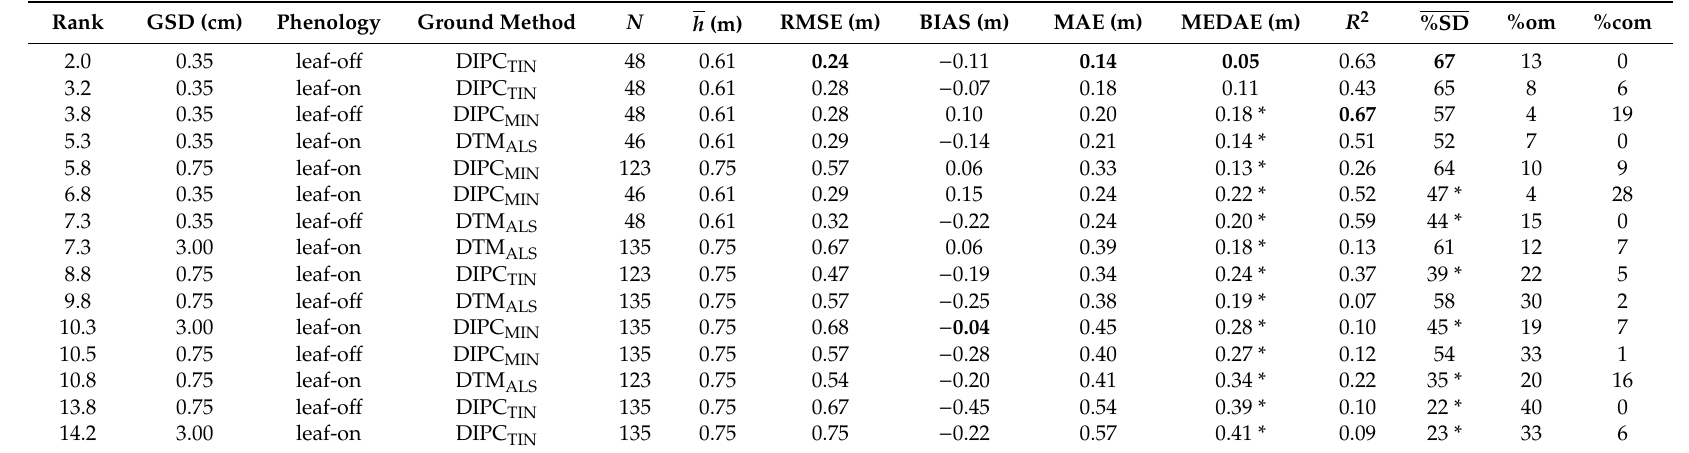
Table 3. Results for seedlings > 30 cm, ordered by the mean value of their ranking in each of the six metrics (e.g., the mean ranking for the 0.35 cm leaf-o ff DIPC TIN is (1 + 6 + 1 + 1 + 2 + 1) / 6 = 2)). Note that the best value for each metric appears in bold. N is the number of seedlings included in each result, h is the mean observed height of those seedlings in m, RMSE is the root mean square error, MAE is the mean absolute error, MEDAE is the median absolute error, R2 is the coe ffi cient of determination, %SD is the mean stochastic dominance of the result as defined in 3.2, and %om and %com are the percentage of omission and commission error respectively. All metrics given in m, except for R2 which is unitless, and %SD, %om and %com, which are given in percent. An asterisk in the MEDAE column indicates that according to the Wilcoxon test, the MEDAE of that result is significantly greater than the MEDAE of the first result in the table ( p < 0.05). An asterisk in the %SD column indicates that the sign test between that result and the first result was significant ( p < 0.05), meaning that that first result yields a significantly larger proportion of seedlings where the absolute residual is less than that of the result with the